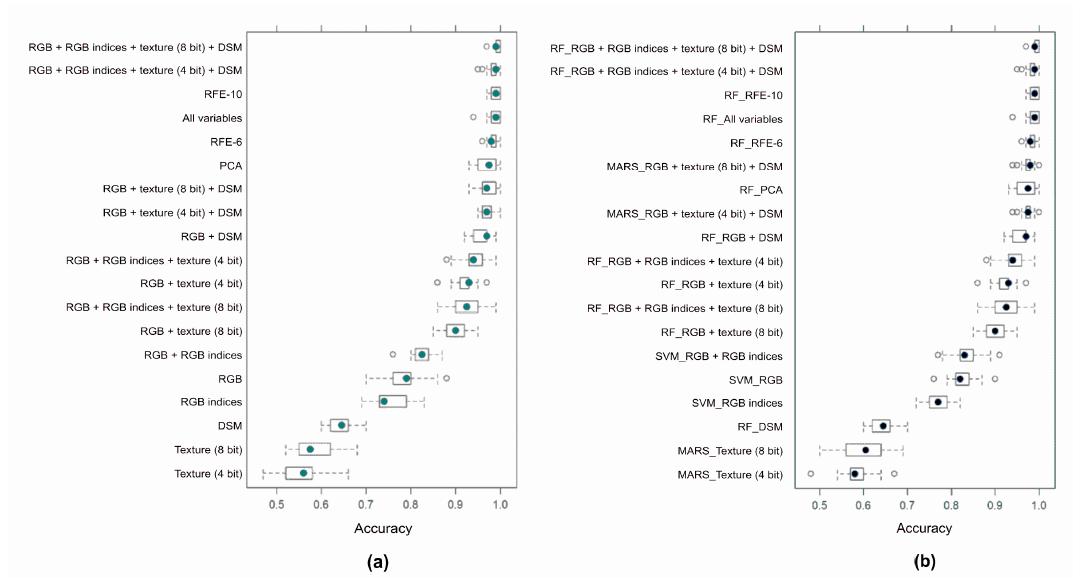
Figure 6. Classification accuracies using different variable sets and classifiers ordered by decreasing OA medians: ( a ) ranking by random forest (RF) models; ( b ) ranking by the best performing models). Boxplots represent the medians (•), interquartile ranges, minimums, maximums (whiskers), and outliers (o) based on 30 models of RKCV.